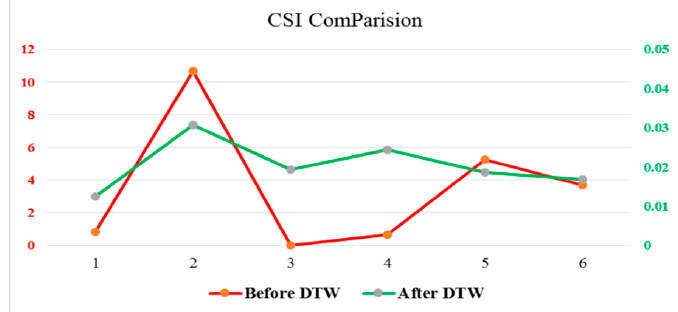
Figure 11. Comparison of comprehensive selection indicator (CSI) before and after DTW pre-processing.